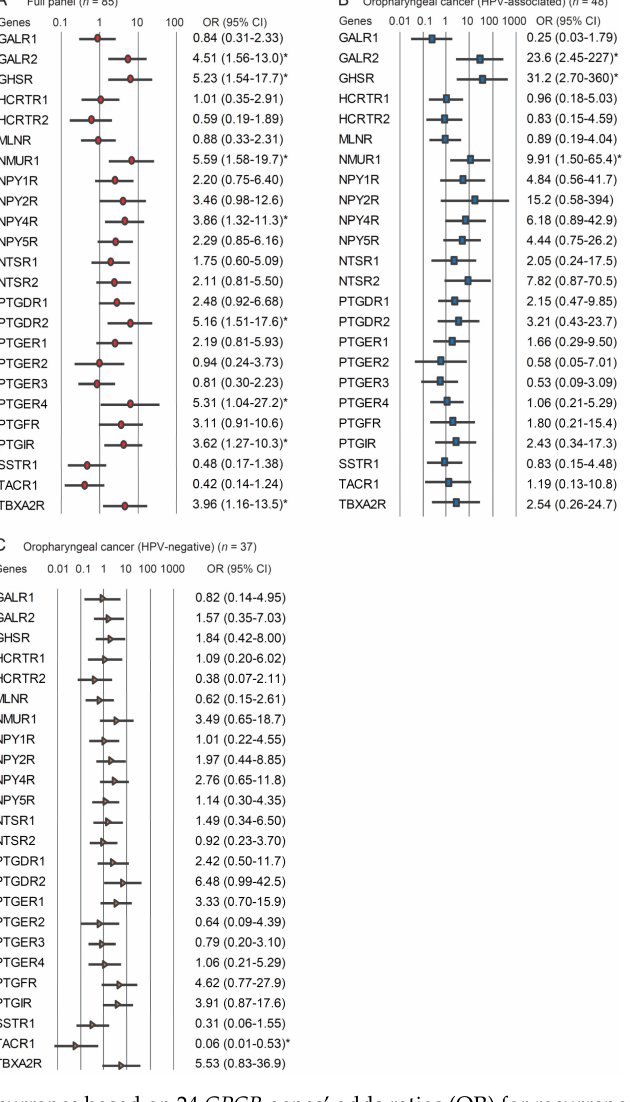
Figure 5. Risk of recurrence based on 24 GPCR genes’ odds ratios (OR) for recurrence were determined using a Cox proportional hazard model adjusted for age ( ≥ 70 vs. < 70 years), sex, alcohol intake, smoking status, and tumor stage (I vs. II–IV). ( A ) Full panel of OPC ( n = 85), ( B ) HPV-associated OPC ( n = 48), ( C ) HPV-negative OPC ( n = 37). OR: odds ratio. CI: confidence interval. * p <